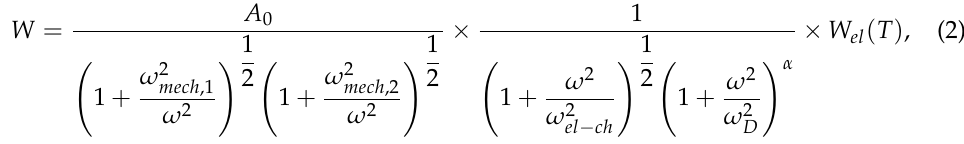
chanical and electrochemical system, which depend on